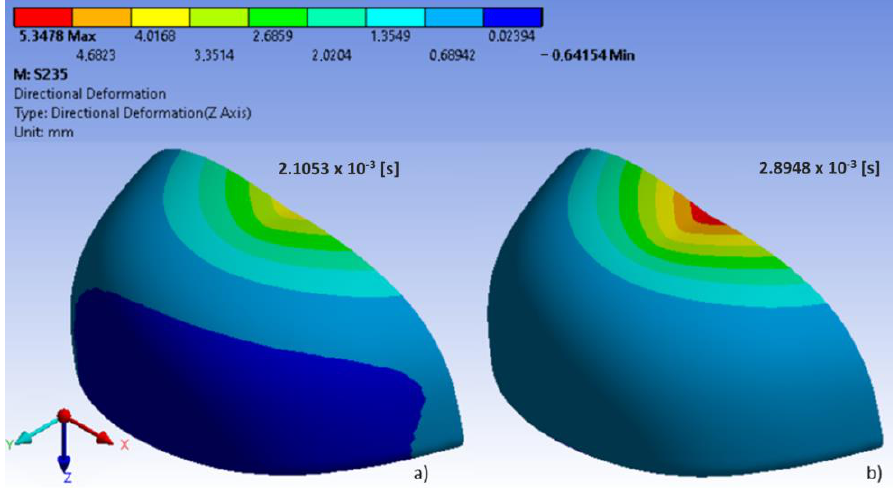
Figure 7. Deformation (approx. 5.3 mm) of steel S235 toecaps in two time steps: (a – b) external side.